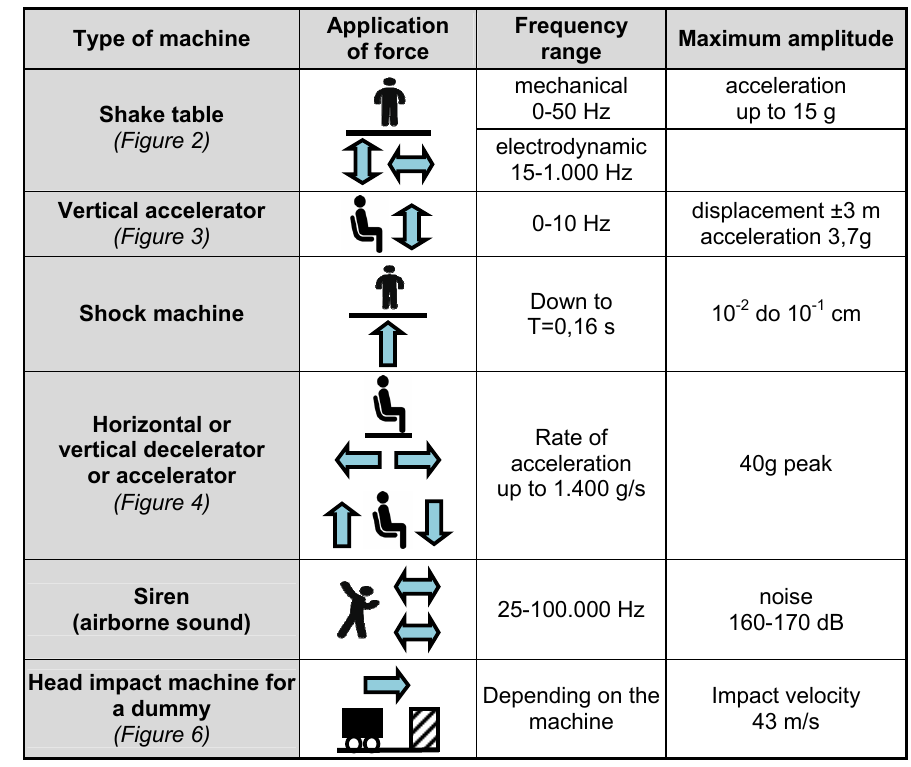
Figure 1 – Summary of the characteristics of shock - impact and vibration machines used for experiments on humans and animals (Frequency range and maximum amplitudes refer to the values used, not to the capabilities of such